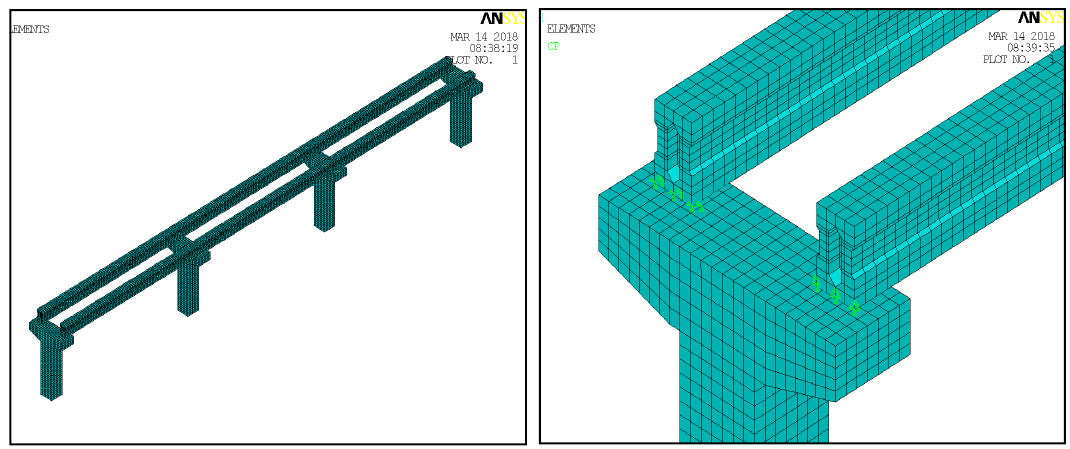
Figure 4. FE model of a monorail bridge.